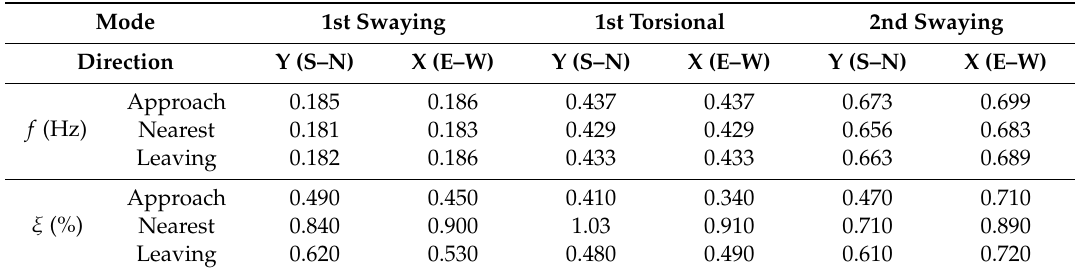
Table 5. Values of natural frequency and damping ratio during three selected periods.